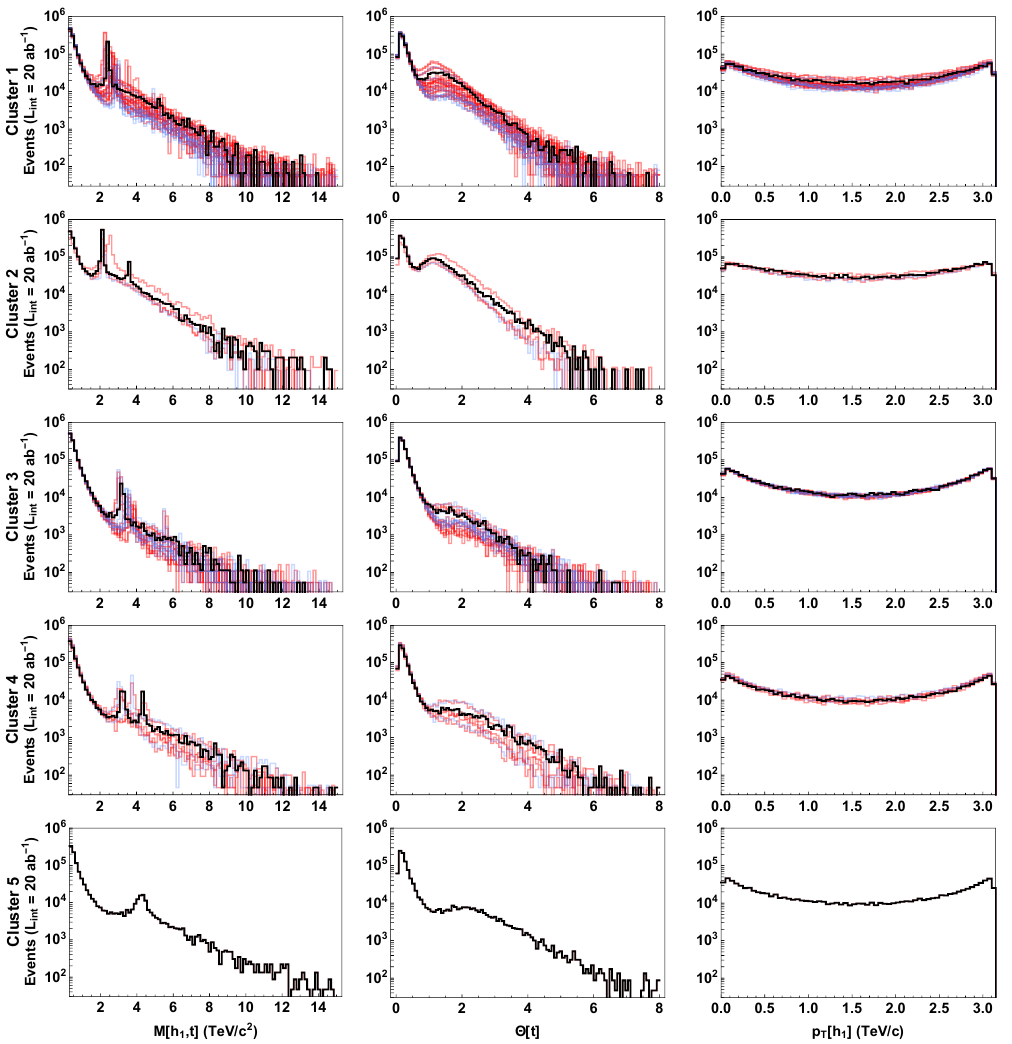
√ Figure 24 . Distributions at s = 100 TeV for the invariant mass of the pair composed by top and most energetic Higgs h 1 (first column), the top quark angle (second column) and the transverse momenta of h 1 (third column), organized in clusters by similarity (clusters 1 through 5). Red and blue curves indicate respectively points in Regions I and II of the MCHM 5 . The benchmark point for each cluster is shown in black, with clusters 1 to 5 containing respectively points E 1 to E 5 in table 7 of the main